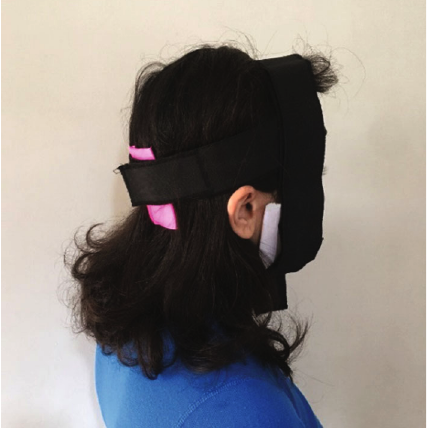
Figure 3: Electrode montages for tDCS. For a-tDCS of the cerebellum, active electrode (anode) was placed 1 cm below inion to target the cerebellum and the returning (cathode) electrode was placed over the right buccinators muscle (taken by authors).